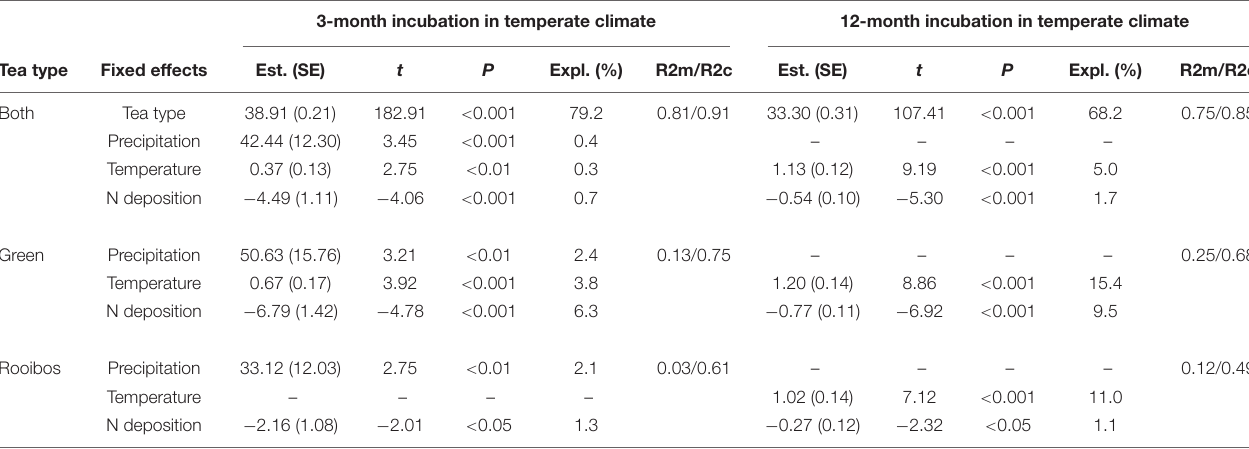
TABLE 4 | The effects of climatic factors and N deposition on the mass loss of Green tea and Rooibos tea after 3 and 12 months of incubation in the temperate